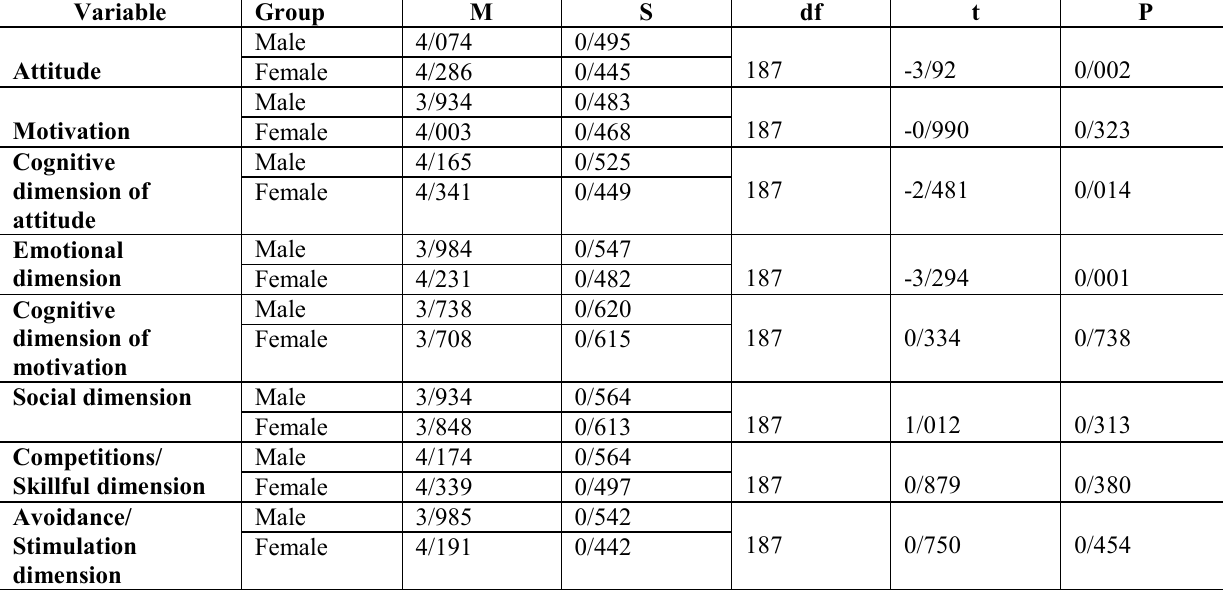
Table 4: comparison of attitude and motivation and their dimensions in male and female with using t-test